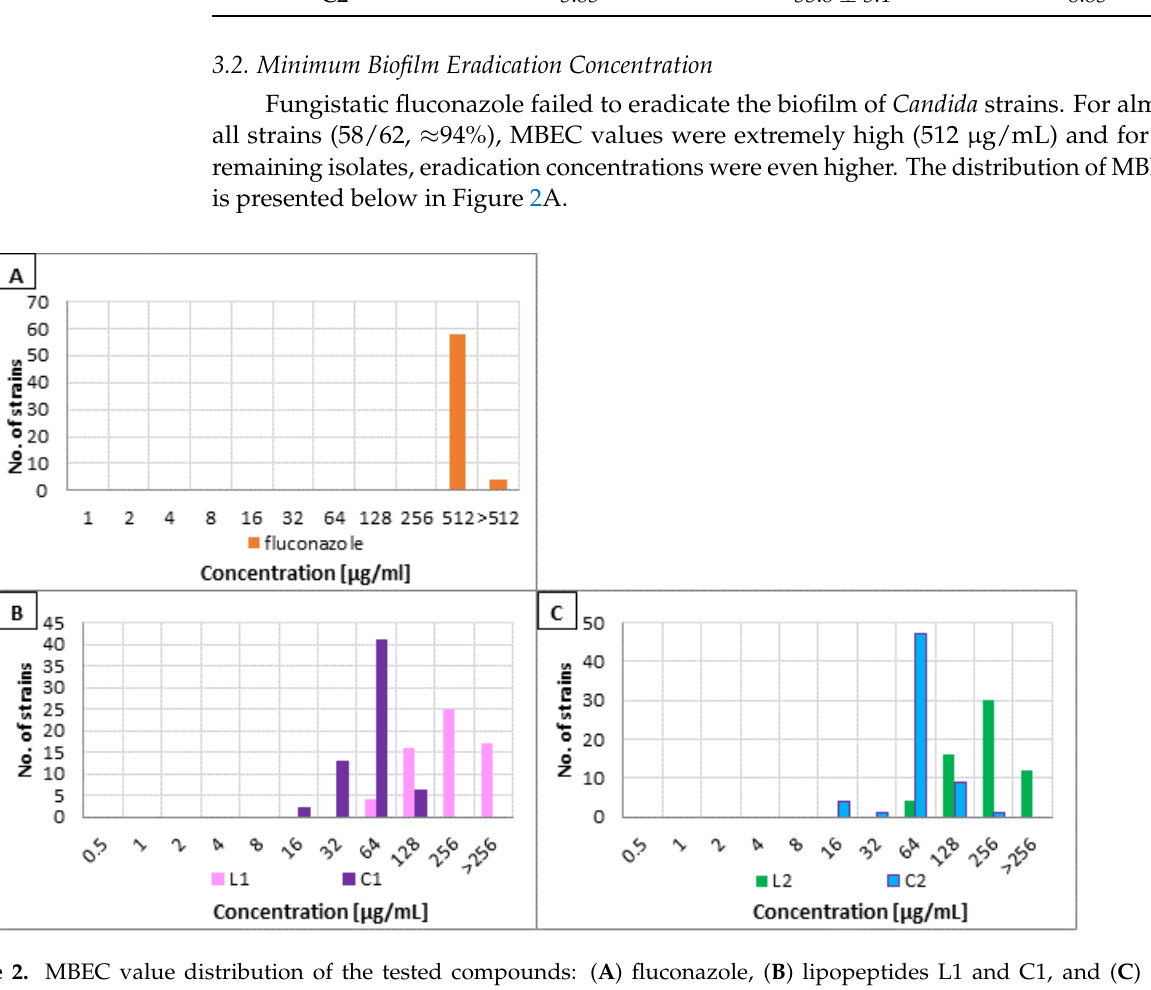
Figure 2. MBEC value distribution of the tested compounds: ( A ) fluconazole, ( B ) lipopeptides L1 and C1, and ( C ) lipopeptides L2 and C2.